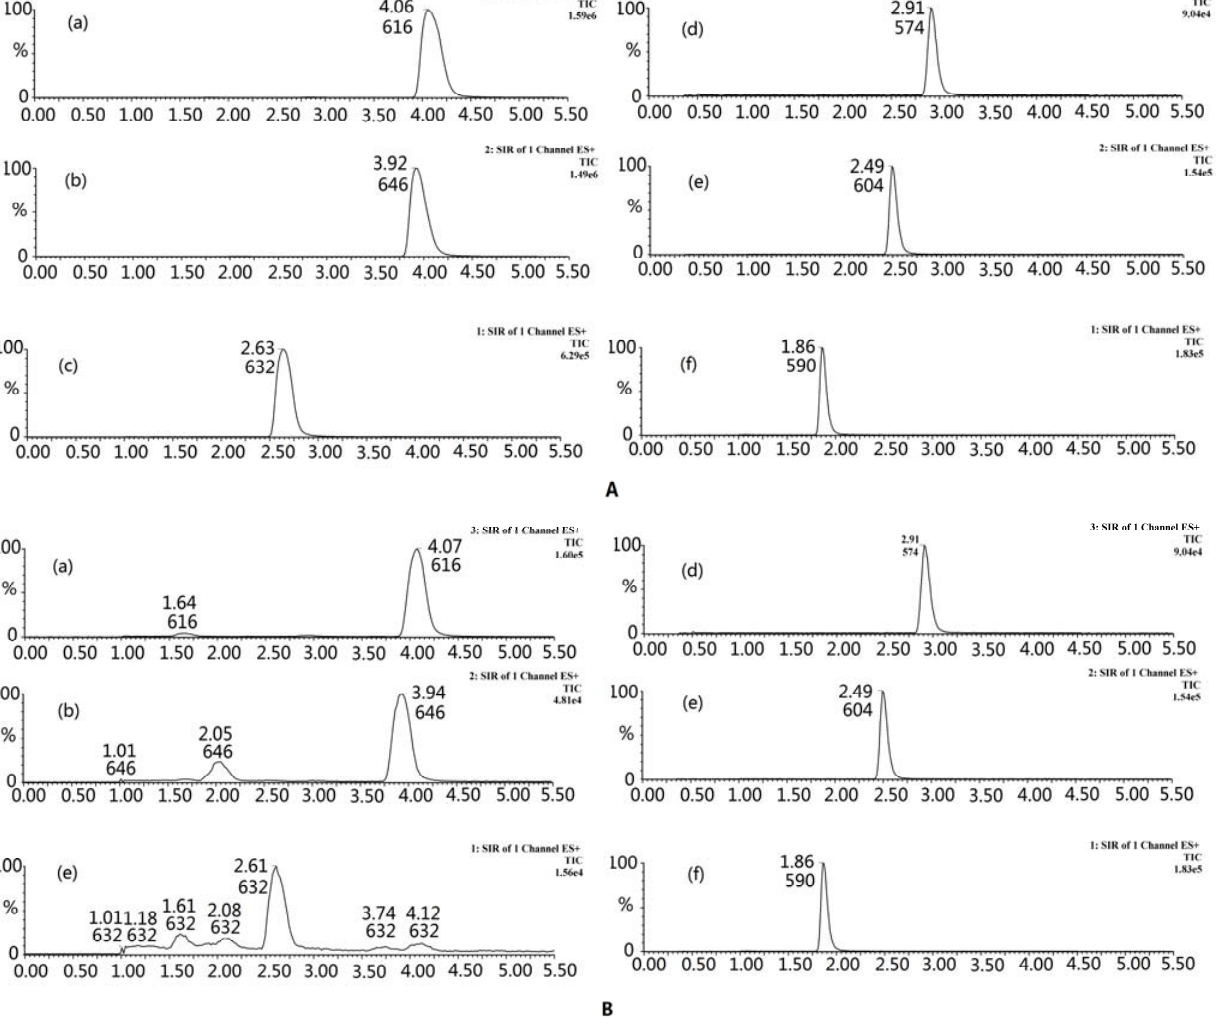
Figure 5. Typical SIR chromatograms of ( a ) HA, ( b ) AC, ( c ) MA, ( d ) BHA, ( e ) BAC,